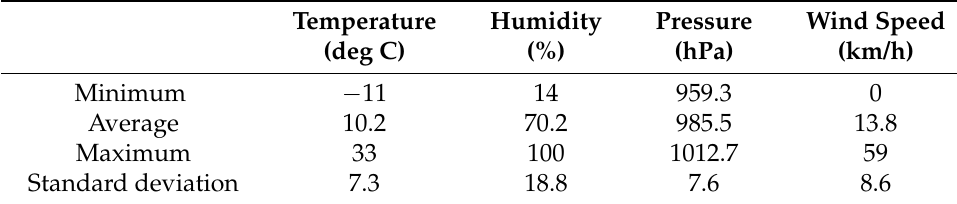
Table 3. Statistical summary of meteorological